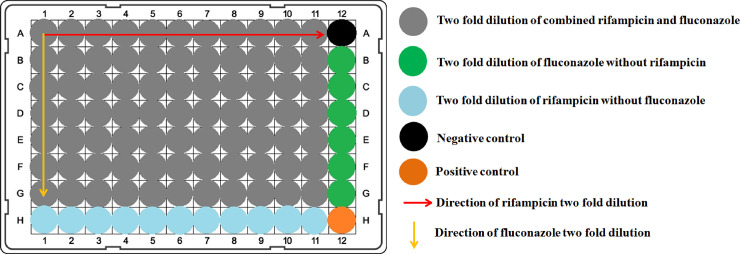
The schematic diagram of checkerboard microdilution assays.Rifampicin was serially diluted along the abscissa while fluconazole was diluted along the ordinate. Each well was inoculated with 2 μl C. albicans inoculum (0.5 McFarland). The highest concentration of fluconazole and rifampicin was in well A1 and the lowest concentration of fluconazole and rifampicin was in well G11. Well A12 was the negative control and well H12 was the positive control.